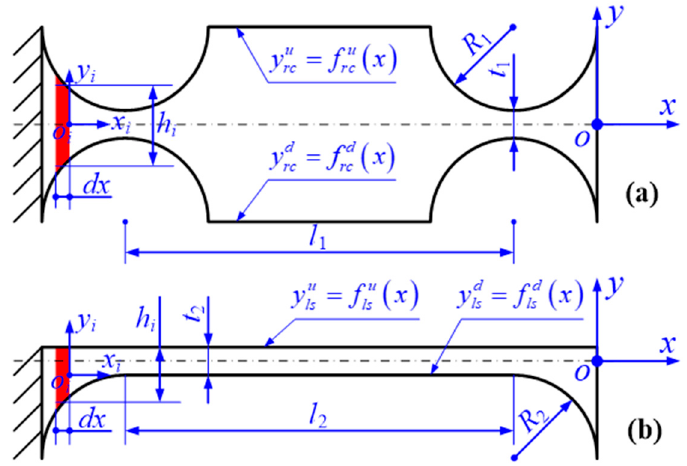
Figure 2. Schematic diagram of the finite beam-based matrix modeling (FBMM) method for two typical flexure beams. ( a ) Right circular flexure beam (RCFB); ( b ) Leaf-spring flexure beam (LSFB).